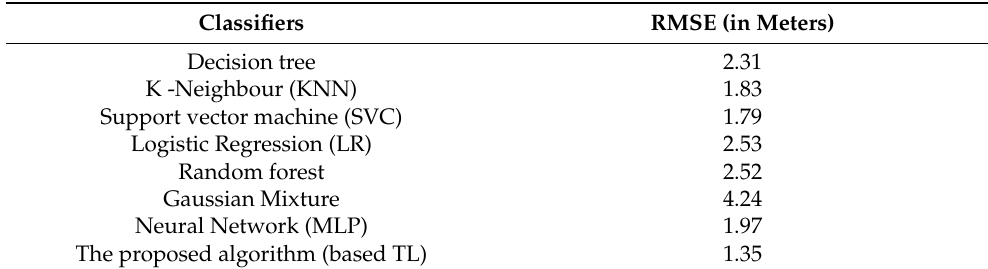
Table 8. Models’ target prediction using the new feature spaces of 15 Wi-Fi access points based on